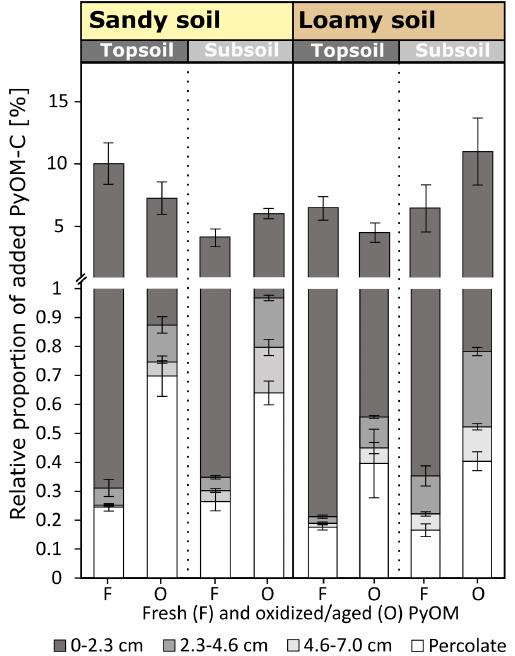
Figure 7. Total mobilized fresh (F) and oxidized (O) PyOM and its relative proportion in the percolates after total percolation and in the soil column in 0–2.3, 2.3–4.6 and 4.6–7.0cm below the soil– PyOM application layer for the sandy and loamy topsoil and subsoil ( ± 1SE). The significance values are presented in Figs. 2 and